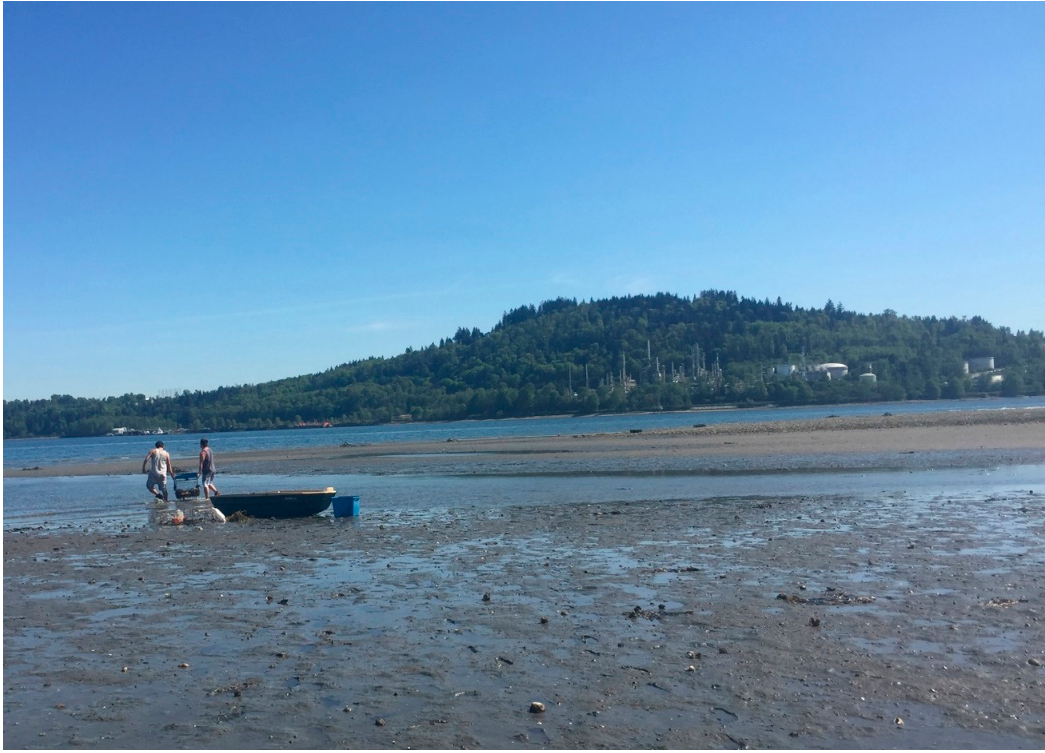
Figure 4. Crab fishers (Photo Credit: Jen Thomas).